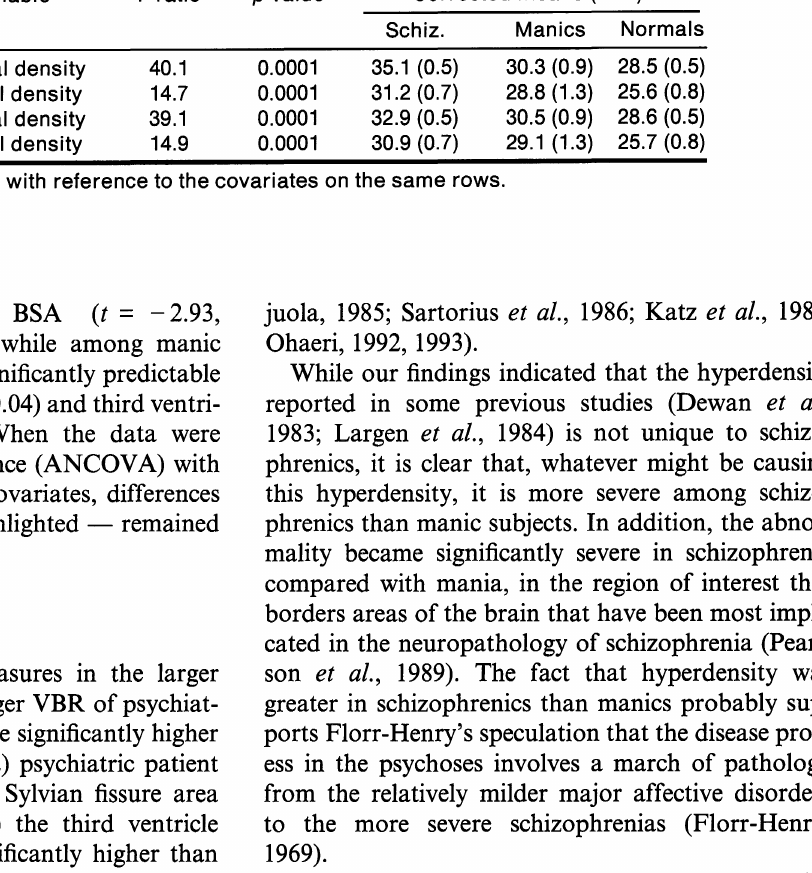
TABLE II. Analysis of covariance (ANCOVA) across diagnostic groups